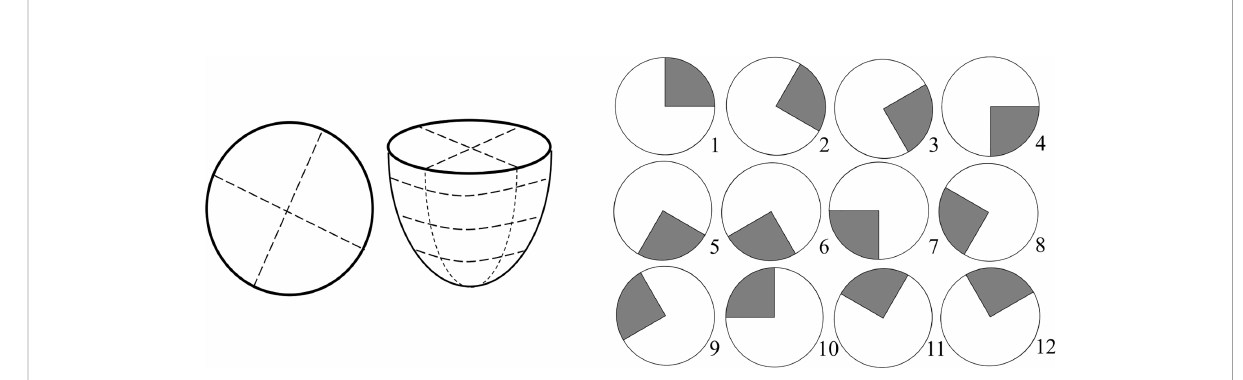
FIGURE 2 Schematic of breast segmentation including vertical (z) segmentation into four bands for a total of 16 segments (left) and diagram of 12 control segment con fi gurations for left breast used to test robustness